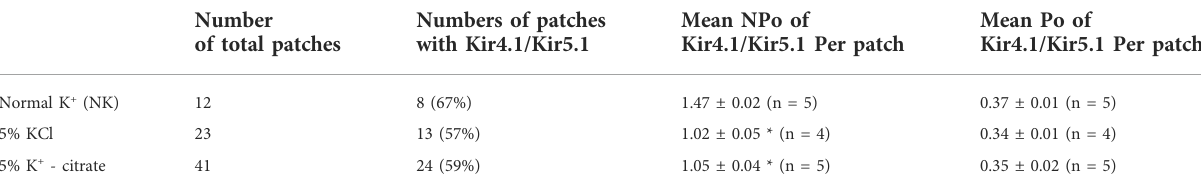
TABLE 2 Effect of 5% KCl and K + -citrate on the probability of fi nding Kir4.1/Kir5.1 in the basolateral membrane of the DCT, mean NPo and mean Po per patch in the female mice. Asterisk indicates the signi fi cant difference in comparison to the group on NK. Number of total